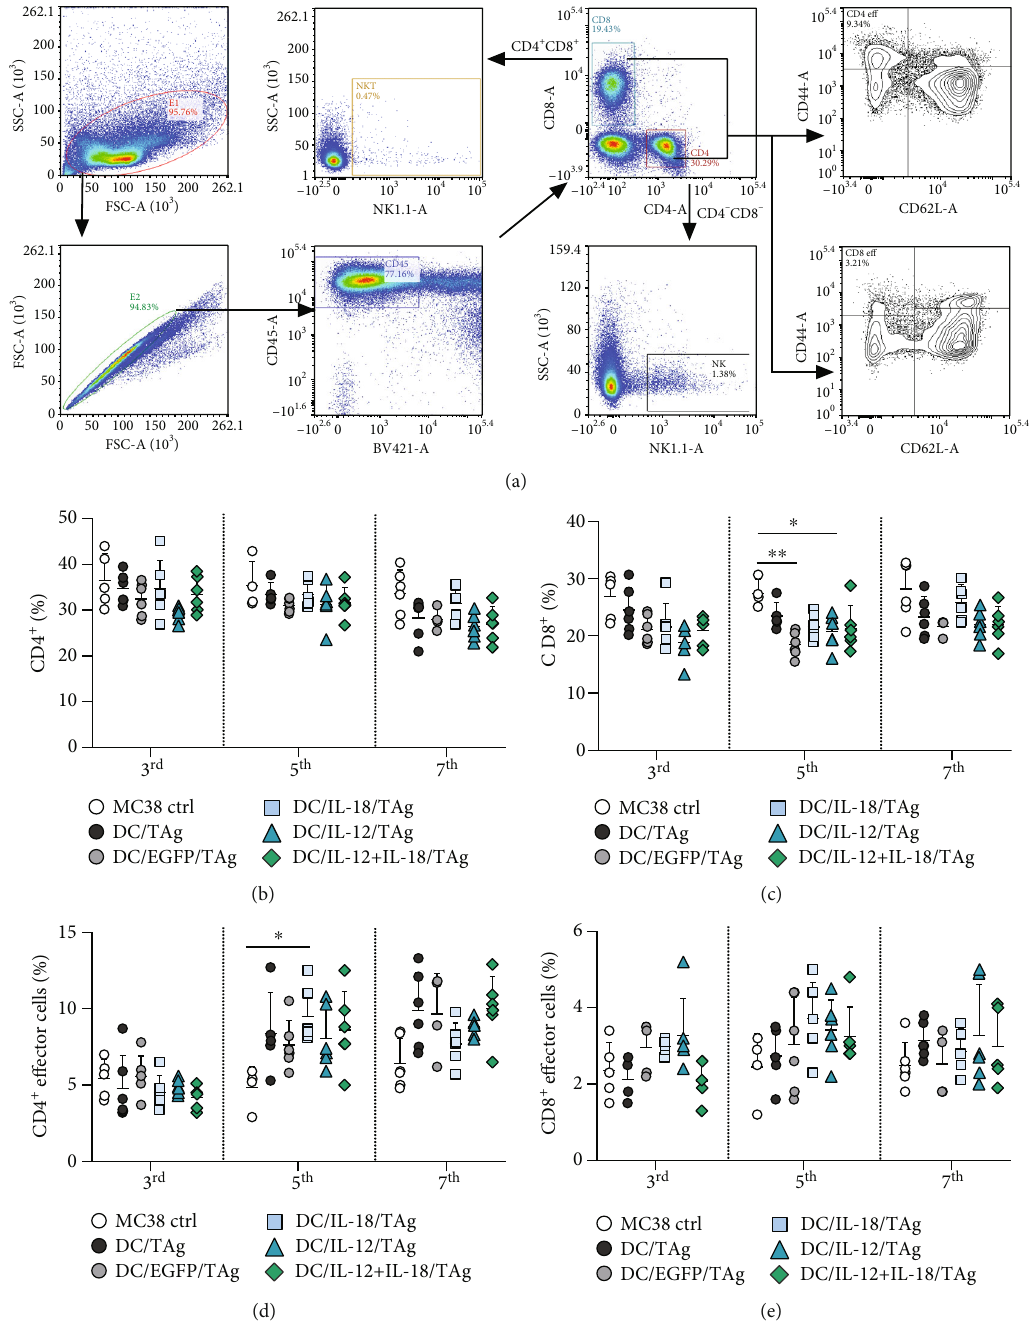
Figure 8: Evaluation of CD4 + and CD8 + T lymphocytes and their activity in tumor-draining lymph nodes after administration of vaccine cells. (a) Scheme of the multiparameter fl ow cytometric analysis of CD4 + and CD8 + T cell, NK and NKT cell, and T lymphocyte activity on the 3rd, 5th, and 7th days after single injection of DCs in tumor-draining lymph nodes. The analysis was started by eliminating debris and cell aggregates; then, live leukocytes (DAPI - CD45 + ) were gated, including CD4 + T cells and CD8 + T cells. NKT cells were identi fi ed among CD4 + CD8 + cells, while NK cells were extracted from the CD4-CD8- cells, based on NK1.1 marker expression. E ff ector T lymphocytes were de fi ned as CD44 + CD62L - . (b) Percentage of CD4 + T lymphocytes in lymph nodes. (c) Percentage of CD8 + T lymphocytes in lymph nodes. (d) Percentage of e ff ector cells among CD4 + T cells in lymph nodes. (e) Percentage of e ff ector cells among CD8 + T cells in lymph nodes. Results are presented as mean + SD calculated for 5-6 mice per group. The di ff erences between the groups were estimated using the parametric Brown-Forsythe and Welch ANOVA test followed by Dunnett ’ s T3 multiple comparison post hoc test ( ∗ p < 0 : 05 , ∗∗ p < 0 : 01